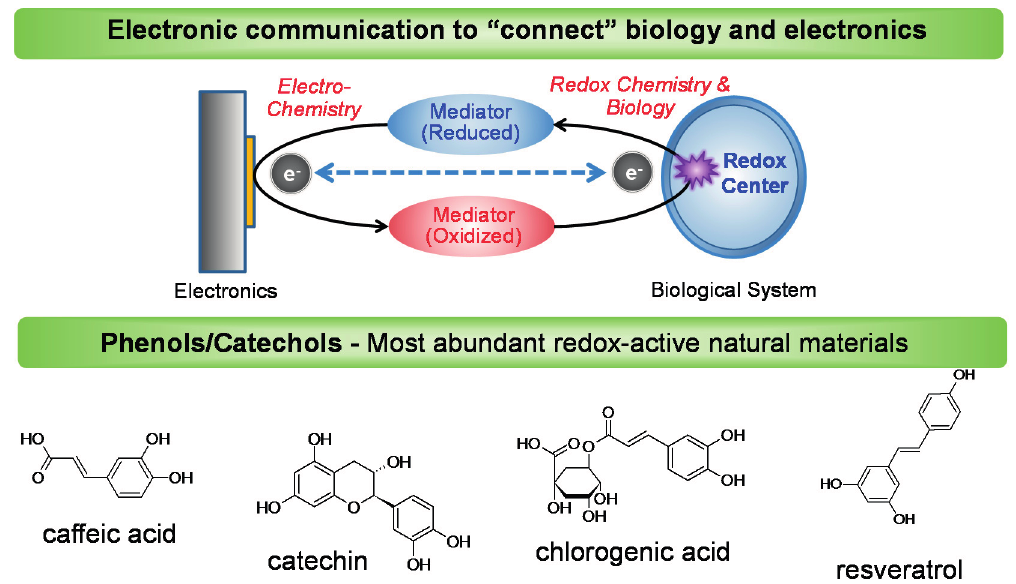
Figure 13. Connecting biology and electronics through electron-based communication relies on coupling electrochemistry with redox-biology. Examples of redox-active phenolic and catecholic natural